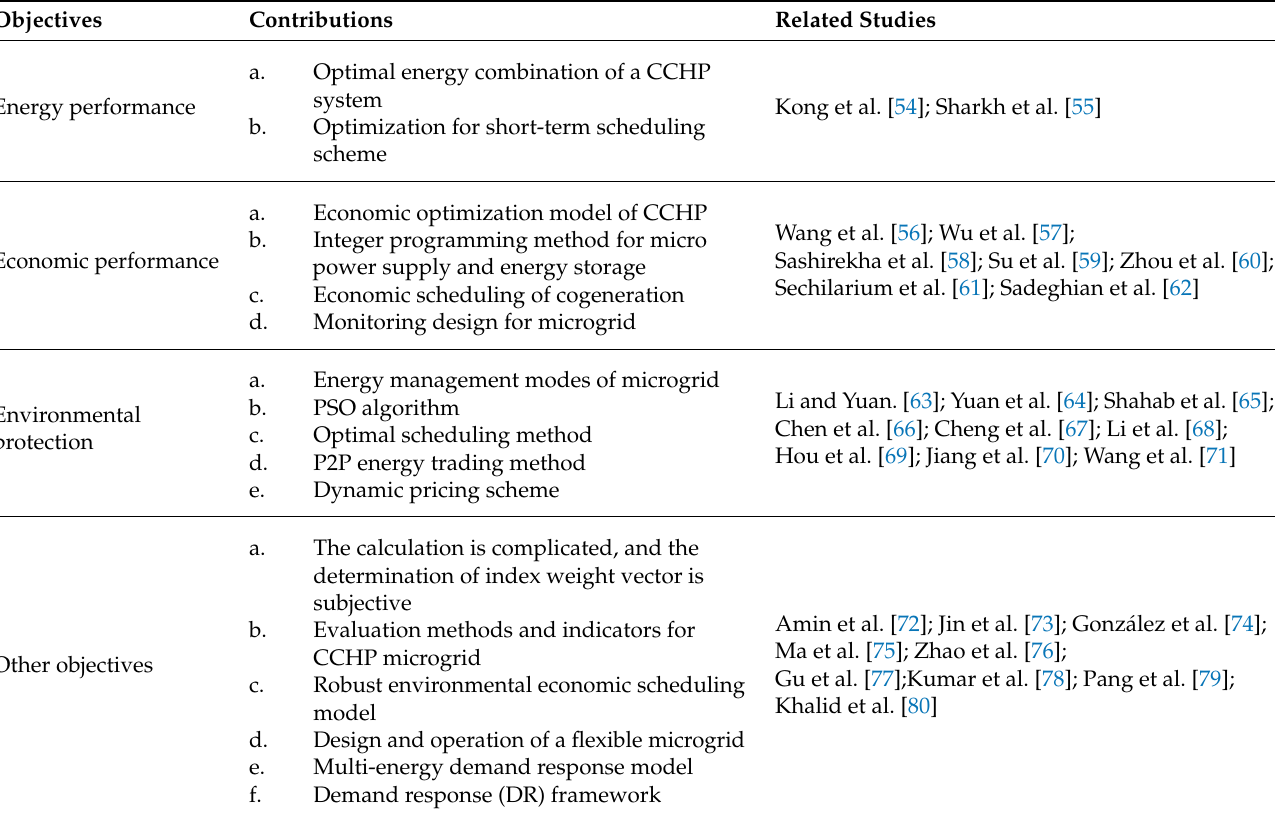
Table 1. The contributions and related studies of the optimization